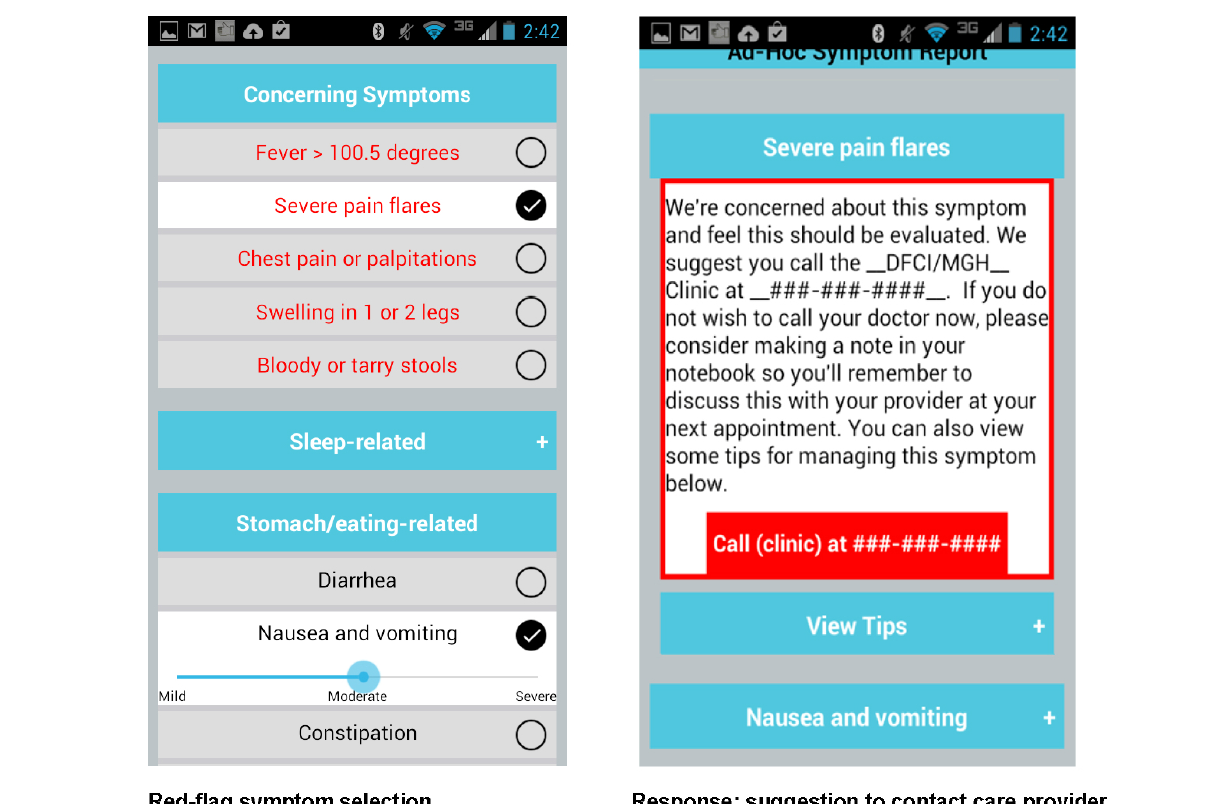
Figure 2. Red-flag symptom reporting.